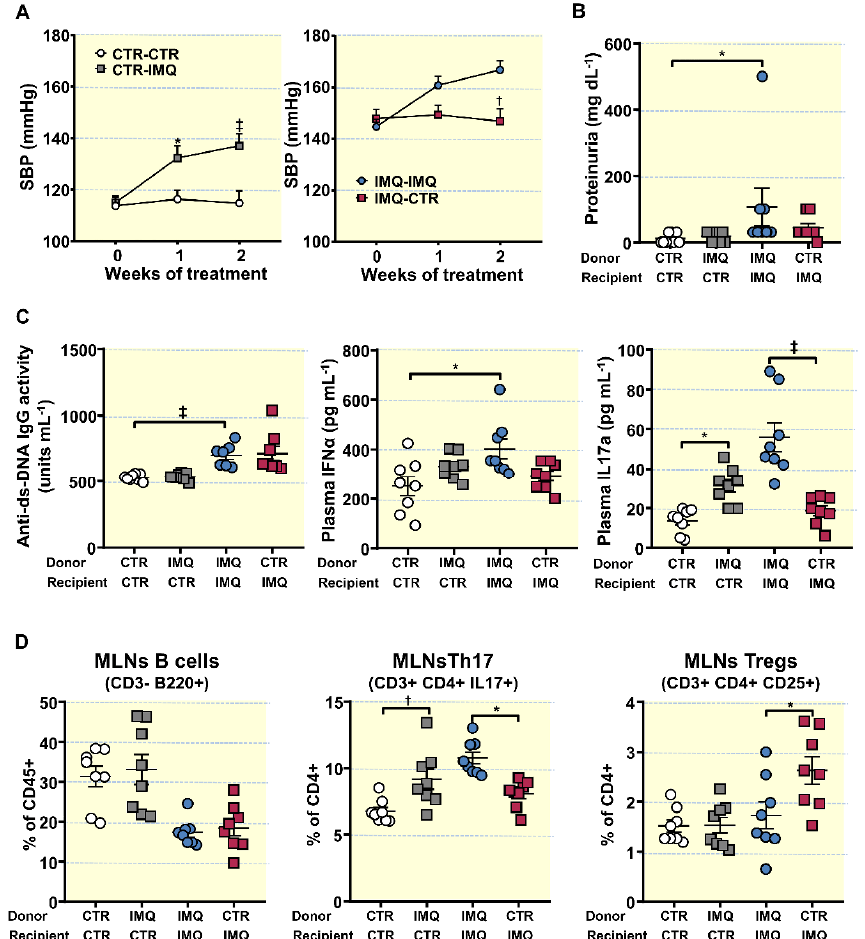
Figure 5. Effects of faecal microbiota transplants (FMT) on the progression of systolic blood pressure (SBP), proteinuria, disease activity, plasma cytokine levels, and lymphocyte proliferation in mesenteric lymph nodes. ( A ) SBP determined via tail-cuff plethysmography. ( B ) Proteinuria, ( C ) Plasma double-stranded DNA (anti-ds-DNA) autoantibodies, interferon (IFN) α , and interleukin (IL)17a levels. ( D ) Populations of relevant lymphocytes in mesenteric lymph nodes: Total B lymphocytes, Th17,